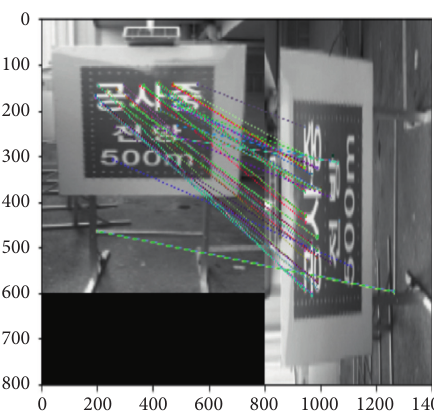
Figure 2: Result of application of RANSAC